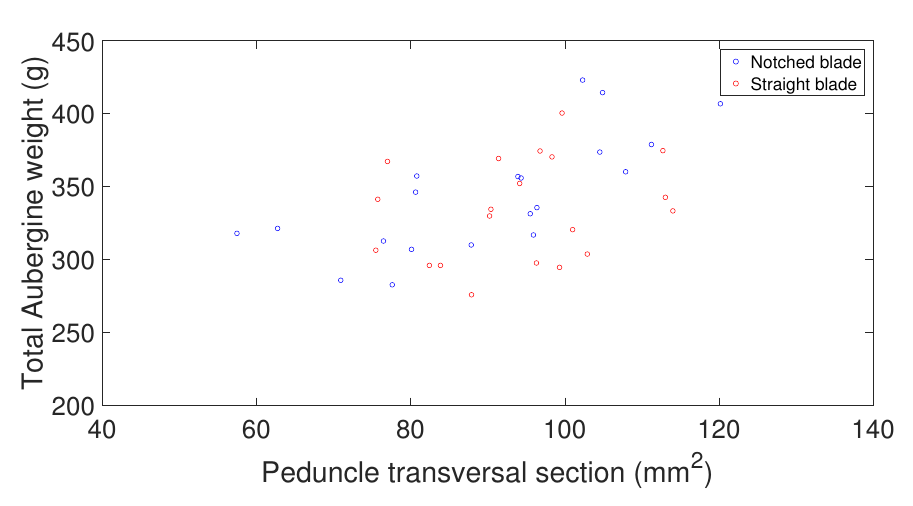
Figure 8. Characterization of the peduncles based on the section and total weight of the aubergine. The peduncles are also divided according to the type of blade with which the shear test was performed. Table 3. Specifications of the 40 aubergine peduncles